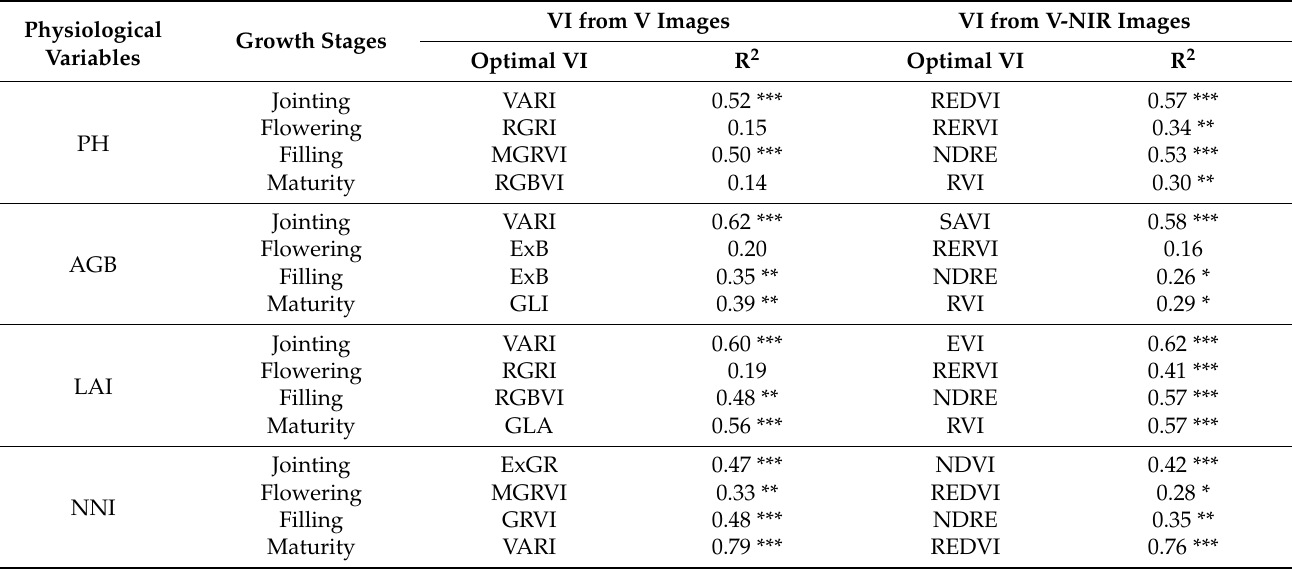
Table 4. Correlation coefficients of rice growth variables with VIs from V images and V-NIR images in different growth